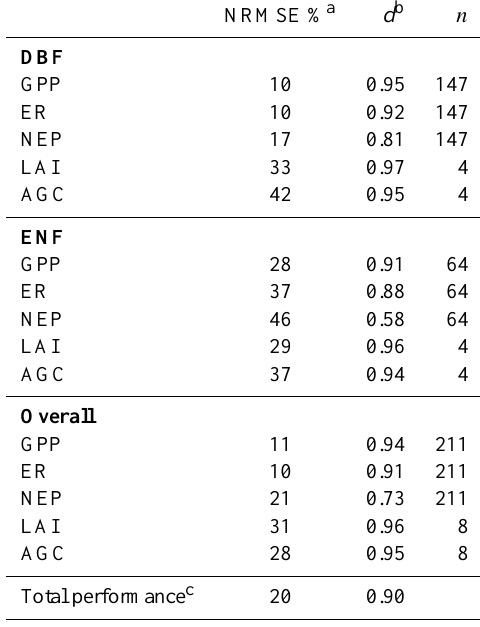
Figure 3. Comparisons of simulated and observed (a) leaf area in- dex (LAI) and (b) aboveground carbon stock (AGC) for all eight sites. index of agreement was 0.95 and 0.96 for AGC and LAI, respectively. Overall, the model evaluation metrics indicated that the model performed better in the DBF sites than in the ENF